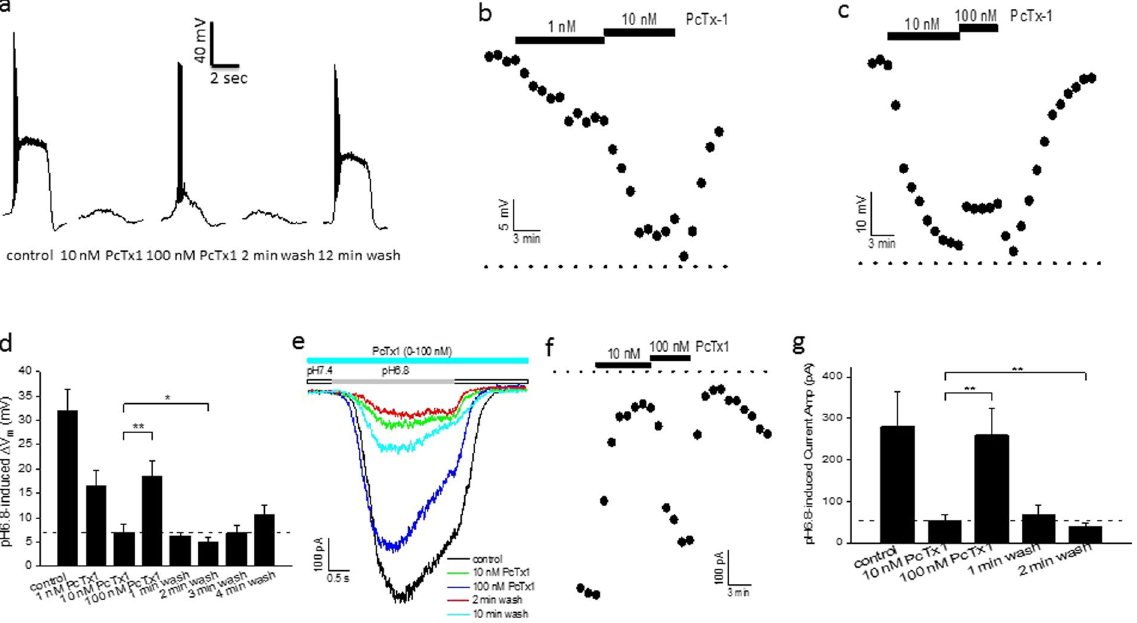
Figure 4. Potentiation of ASIC1a/2a by PcTx1 in rat cortical neurons. ( a ) Traces of pH6.8-induced membrane depolarization from a single neuron in the absence and presence of PcTx1. (b and c) Time courses of PcTx1 modulation for the same neuron as in ( a ). The dotted lines at the bottom represent the baseline. Note the dip in membrane potential to below that in the presence of 10 nM PcTx1 upon initial wash of 10 nM ( b ) and 100 nM ( c ) PcTx1. ( d ) Averages of pH6.8-induced depolarization from multiple neurons (n = 8, 4, 8 and 8 for 0, 1, 10 and 100 nM PcTx1, respectively). The horizontal dashed line represents the value in the presence of 10 nM PcTx1. PcTx1 was applied in the order of increasing concentration and the wash data were recorded upon wash-off of 100 nM PcTx1. ( e ) Traces of pH6.8-induced current from a single neuron in the absence and presence of PcTx1. ( f ) Time course of PcTx1 modulation from the same neuron as in ( e ). The dotted line at the top represents the baseline. Note the lower current amplitude than that in the presence of 10 nM PcTx1 upon first removal of 100 nM PcTx1. ( g ) Averages of pH6.8-induced currents from multiple neurons (n = 10 each for 0, 10 and 100 nM PcTx1, respectively). The horizontal dashed line represents the value in the presence of 10 nM PcTx1. PcTx1 was applied in the order of increasing concentration and the wash data were recorded upon wash- off of 100 nM PcTx1. For all the experiments in Fig. 4, the conditioning pH was 7.4 and the test pH of 6.8 was applied for 2–3 sec before returning to pH7.4. This pH application protocol was repeated once every 60